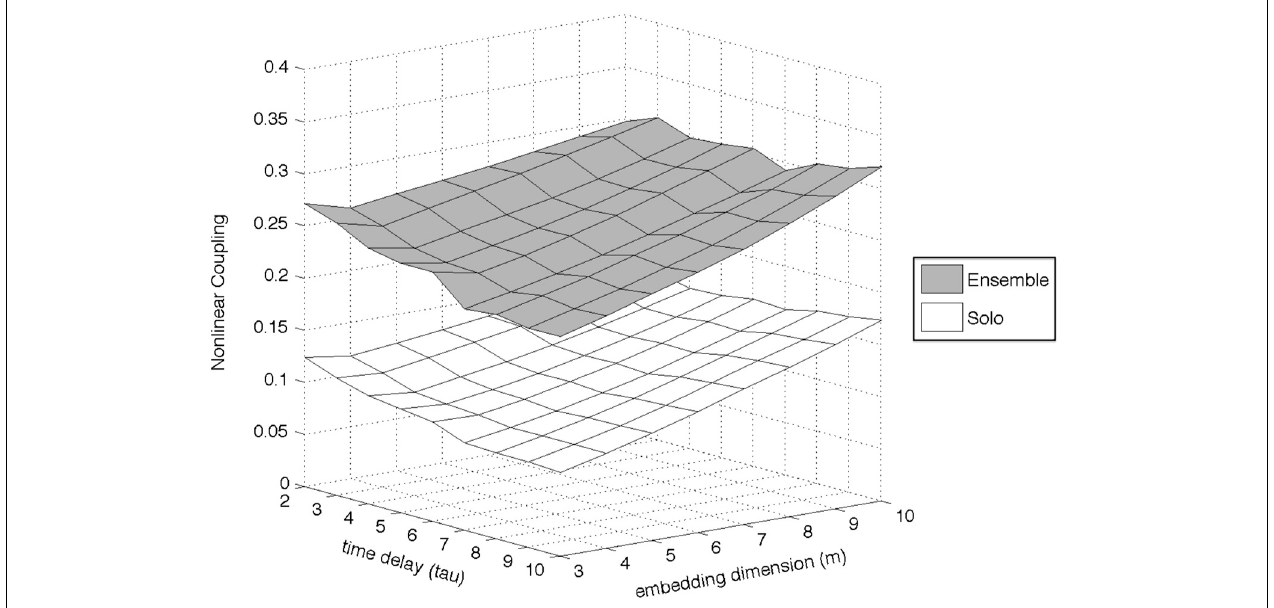
FIGURE 8 | Example of the effect of parameter choice (embedding dimension and time delay) on the estimation of the Nonlinear Coupling coefficient, for the Dynamics dimension of exercise D1.